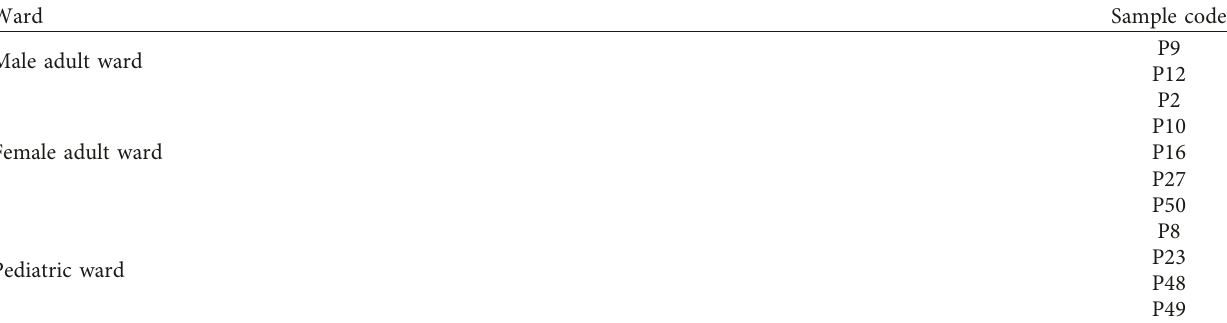
Table 2: Source of A. baumannii isolates from inpatients in different hospital wards. Ward